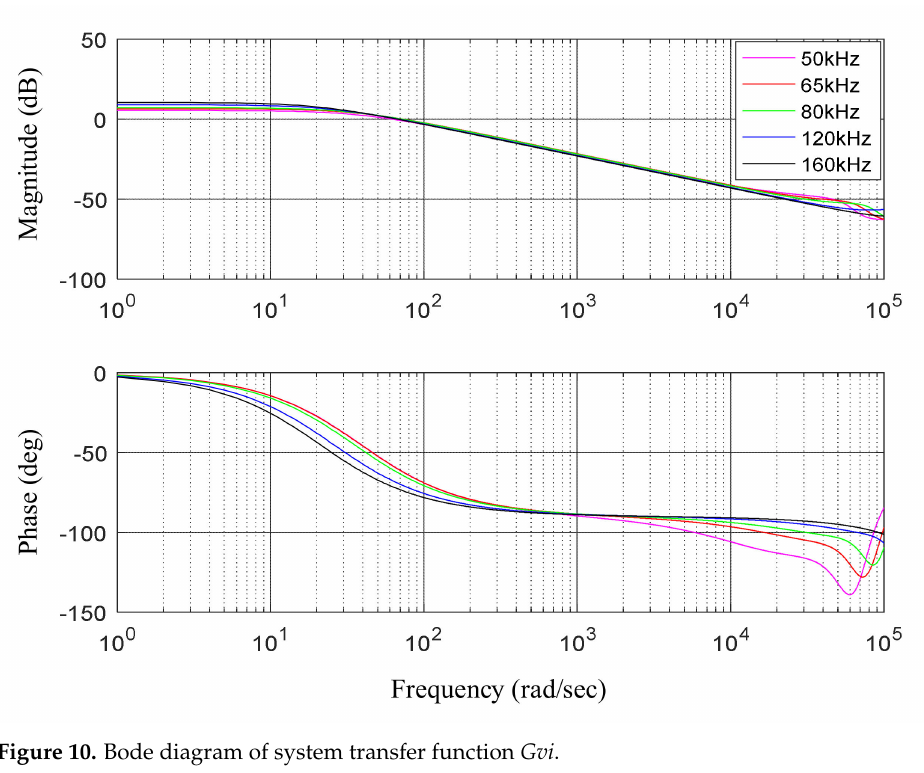
Figure 10. Bode diagram of system transfer function Gvi .